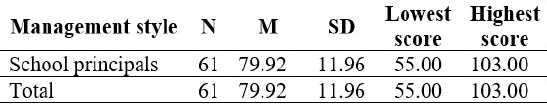
Table 2. Basic statistical indicators for management style